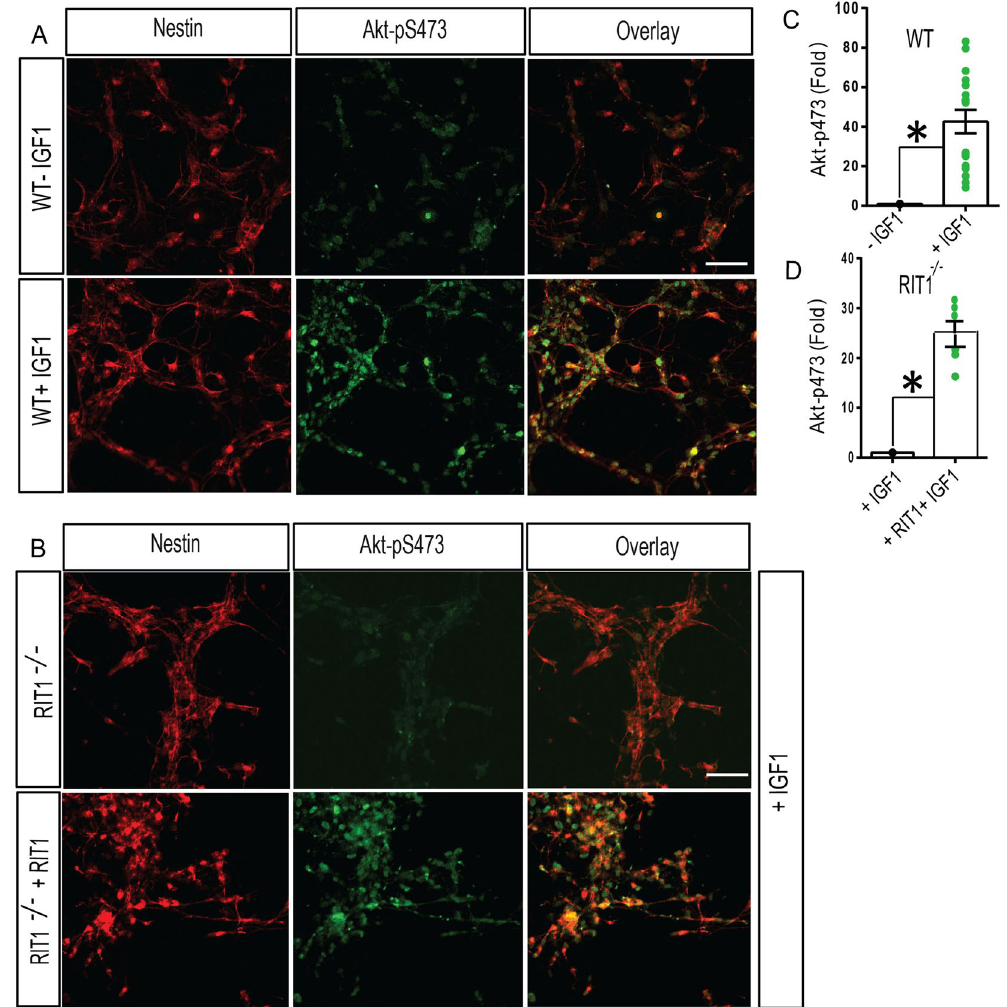
Figure 7. RIT1 contributes to IGF-1-mediated Akt activation. ( A , B ) Representative confocal images of WT, RIT1 − / − , or RIT1 − / − HNPCs completed by re-expression with Myc-RIT1. HNPC cultures were co- immunostained for phospho-Akt S473 ( green ) and Nestin ( red ) following vehicle or IGF-1 stimulation (50 ng/ ml; 24 h). Scale bar, 20 μ m. ( C , D ) Quantification of phospho-Akt S473 levels following IGF-1 stimulation of the indicated HNPC cultures is presented as mean ± SEM calculated from three separate experiments ( * p < 0.01, nonparametric one tailed